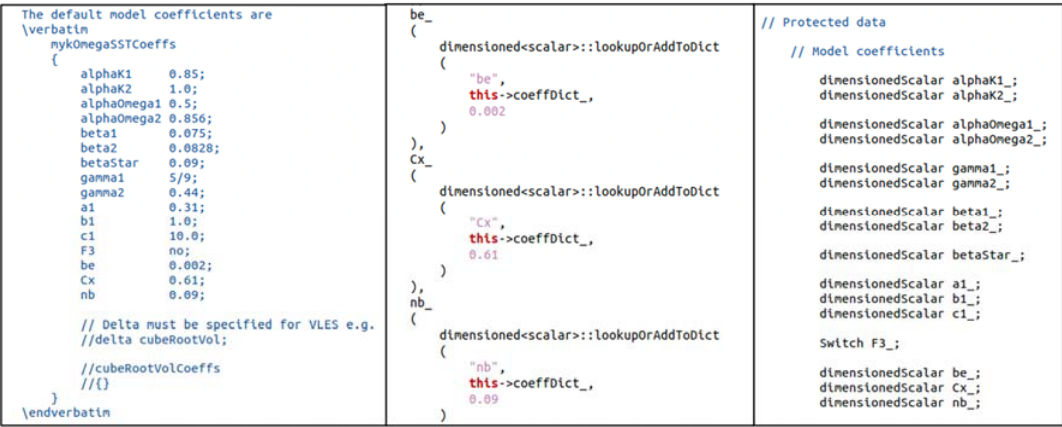
Figure 5. The recommended values and model